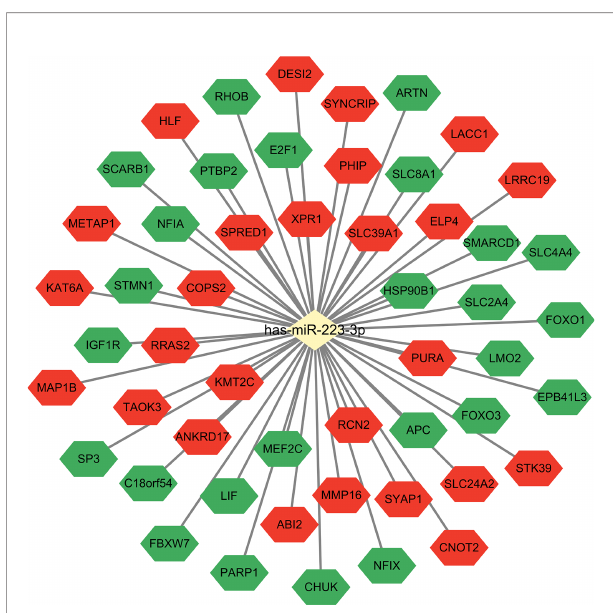
FIGURE 2 | MiR-223 target genes. Combined with miRTarBase database, the target gene network of miR-223 was constructed. The green shapes represent experimentally validated target genes that have been reported, and the red shapes represent target genes that have not been experimentally validated yet.